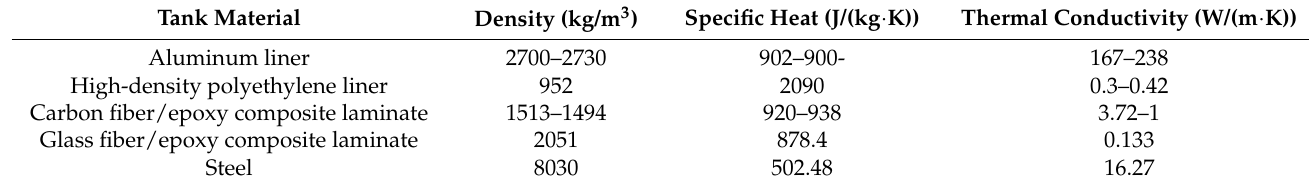
Table 5. Heat transfer properties of different tank materials. Data retrieved from